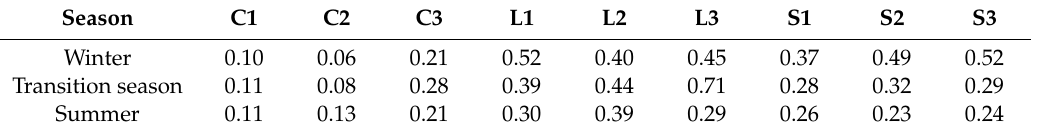
Table 4. The standard deviation of wind speed (m/s) for each measurement point.